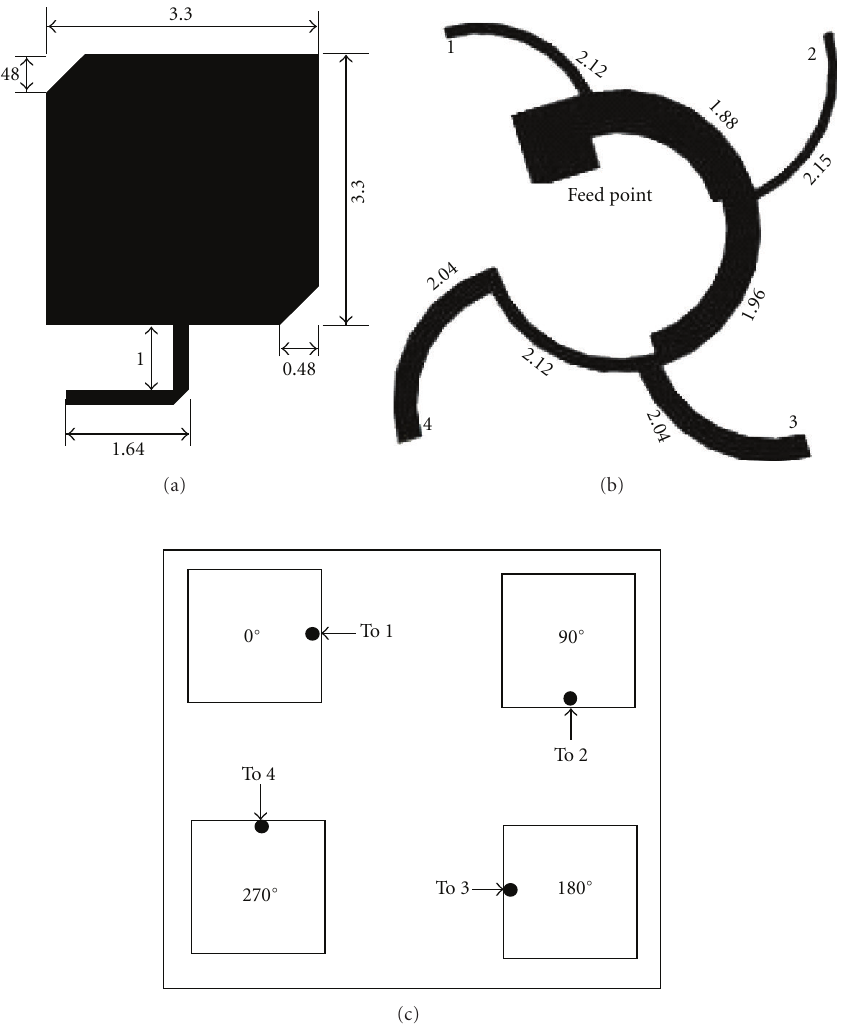
Figure 1: (a) Configuration of the single patch element, (b) the proposed single series-parallel sequential rotation feeding network, and (c) four patch elements (unit: